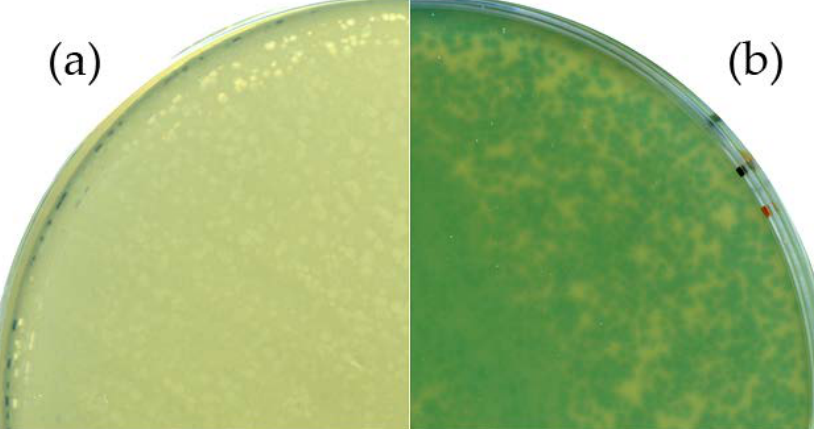
Figure 3. Phenotypic analysis of the Goe1 Δc00180:: bgaB mutant. For both experiments, X-Gal-supplemented agar plates were used. B. subtilis TS01 was infected with ( a ) the Goe1 wild-type; and ( b ) Goe1 Δc00180:: bgaB . The blue color in the case of the bgaB insertion mutant indicates β -galactosidase activity, while no activity could be observed for the control experiment with the Goe1 wild-type.